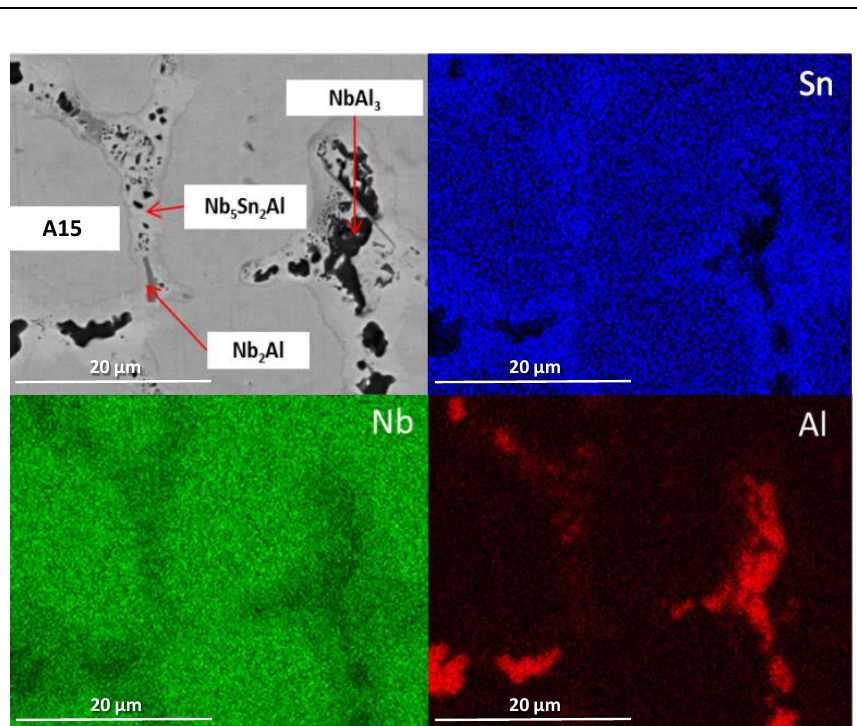
Figure 3. BSE image and X-ray element maps of IP4-HT 900 °C/100 h (for colour, see online version) .